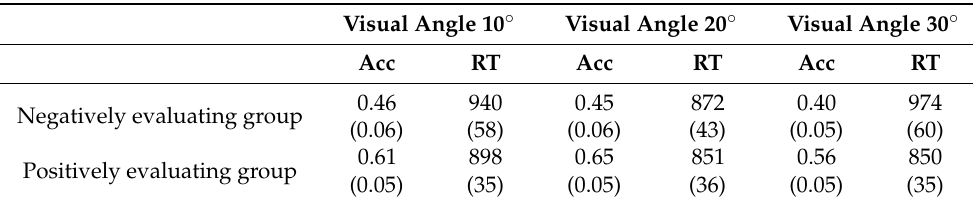
Table 1. The accuracy rates and response times of the two experimental groups in the UFOV task. The value within brackets denotes the standard